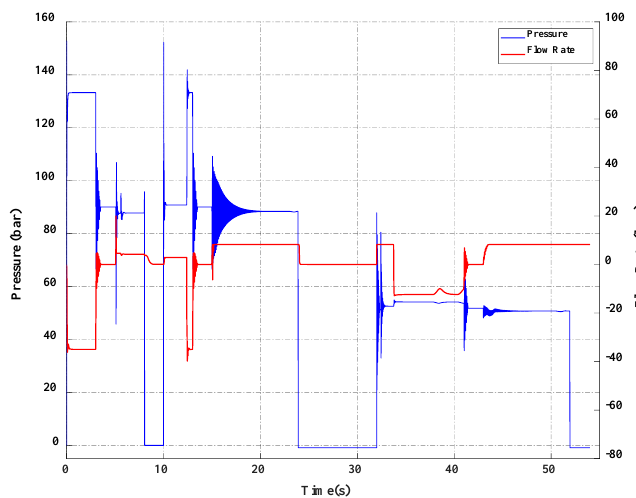
Figure 11. Comparison control signal of each valve ( a ) and torque command ( b ).